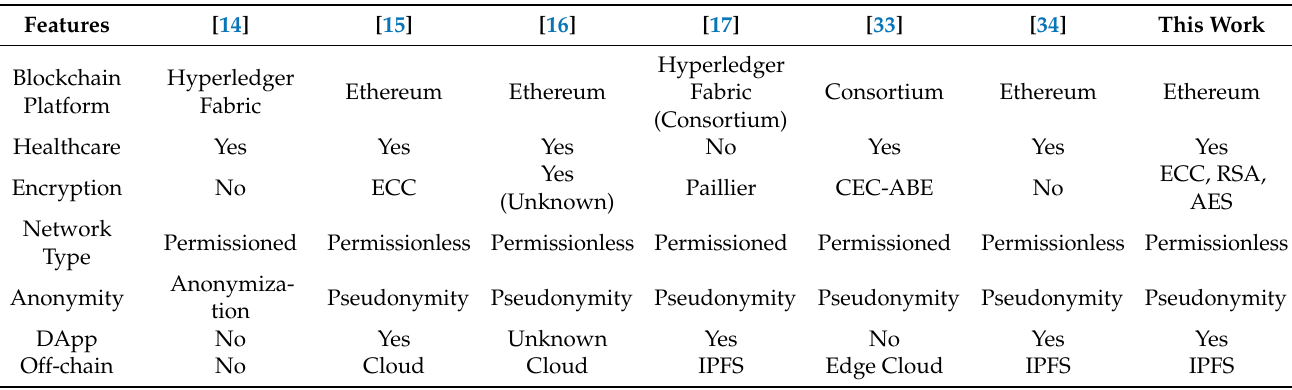
Table 1. Comparison between the work-related features